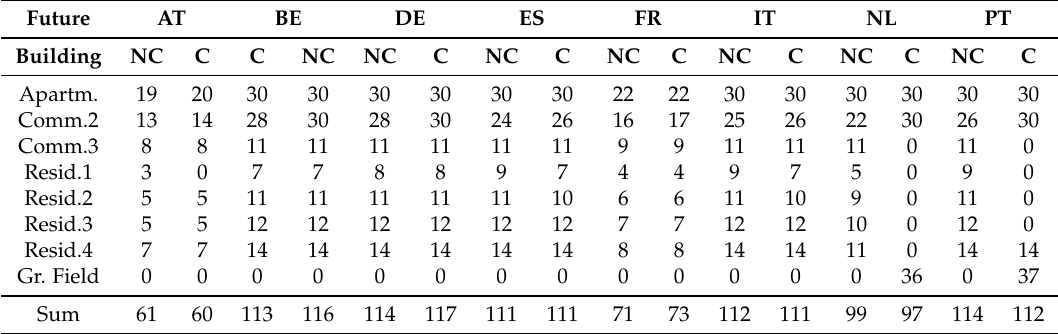
Table 3. Installed PV per building for no commnunity (NC) and community (C), demand scenario future, in [kWp], rounded values.